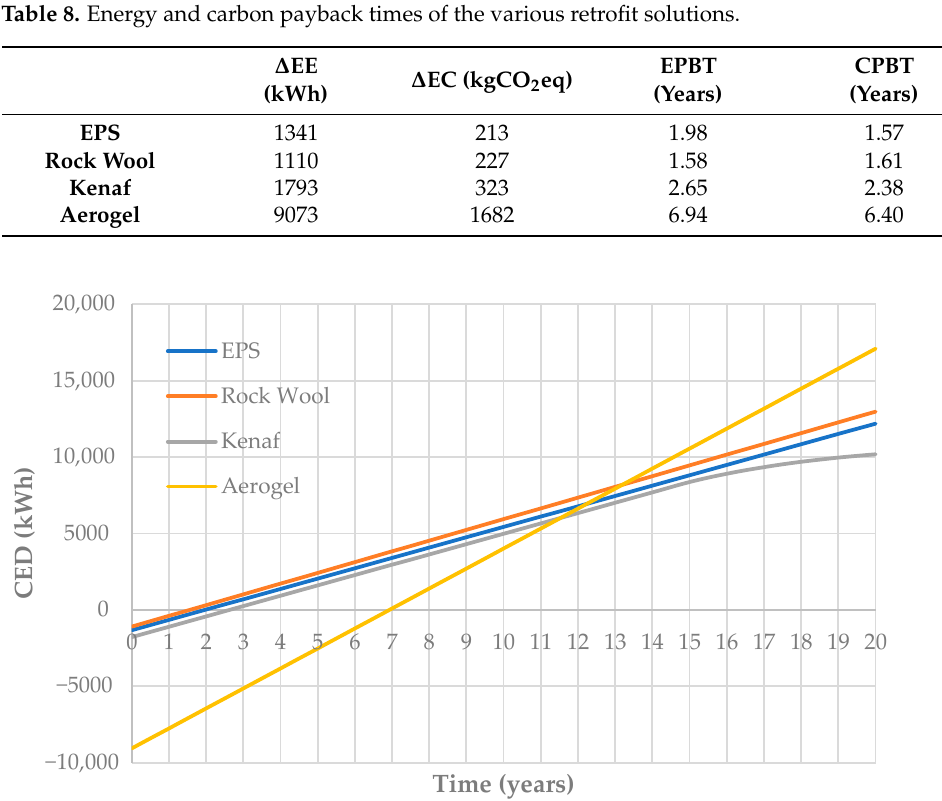
Figure 10. Cumulative energy demand for every retrofit intervention (positive values stand for energy saved).